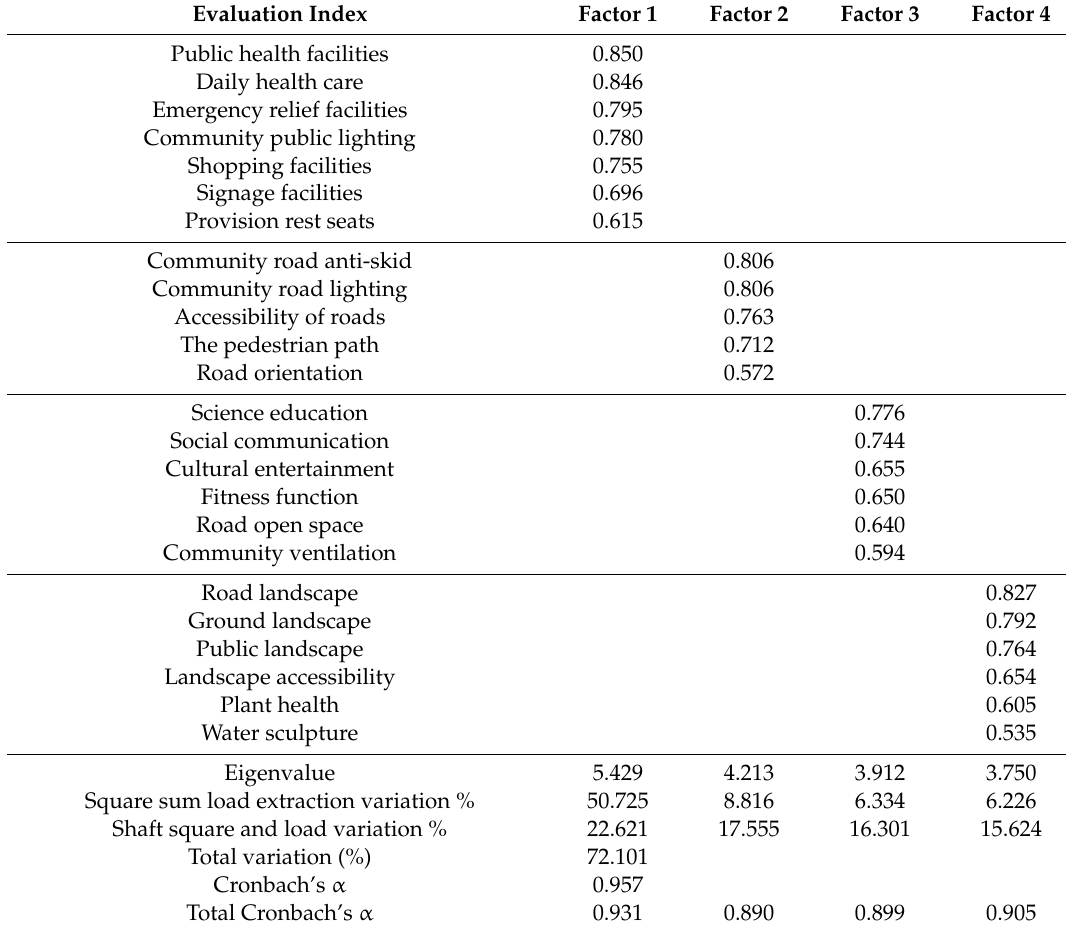
Table 5. The result of factor analysis